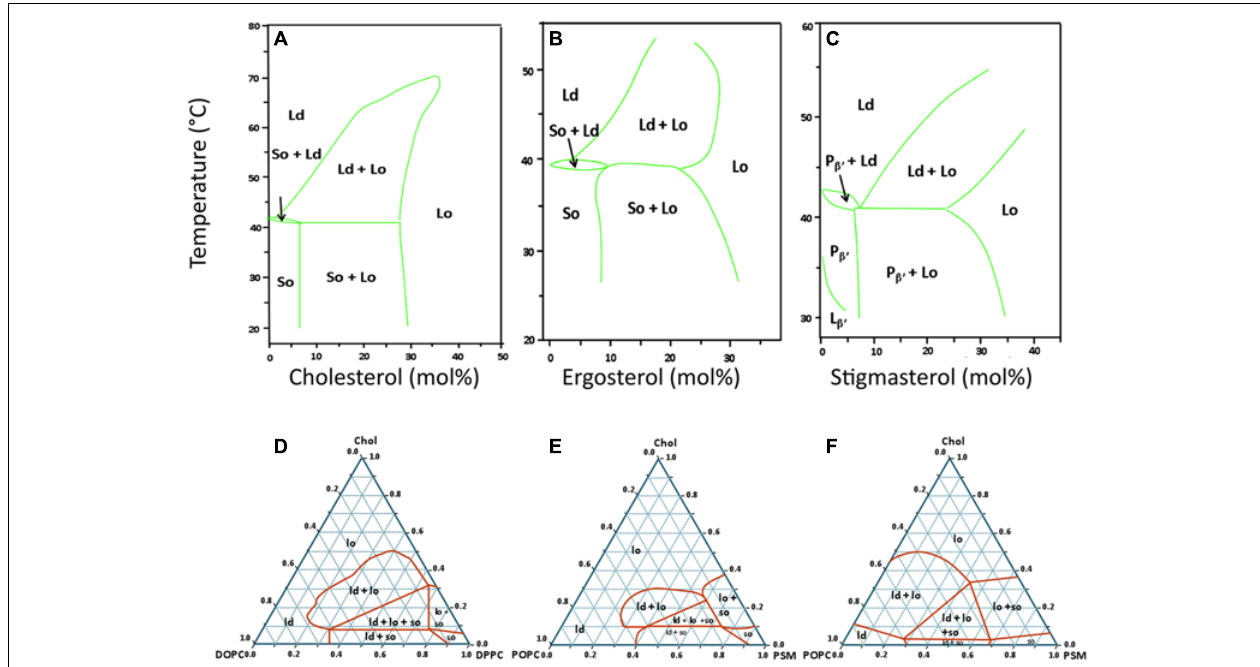
FIGURE 1 |Typical lipid phase diagrams used in the study of sterol-related membrane domains. Top row: temperature – composition binary phase diagrams for mixtures of DPPC with three different sterols (A) Cholesterol (animals; Sankaram andThompson, 1991) and references therein, (B) Ergosterol (fungi; Hsueh etal., 2005), (C) Stigmasterol (plants;Wu etal., 2006).These three diagrams were selected to show that, for the same saturated lipid (DPPC), the type of phase diagram and the regions of coexistence of Ld, Lo, and/or So phases are similar for the three eukaryotic kingdoms. For panel C , the techniques used allowed to distinguish two types of gel phases below the T m : the tilted gel phase ( L β (cid:3) ) and the periodic quasi-lamellar gel phase ( P β (cid:3) ). Bottom row: ternary phase diagrams for mixtures of cholesterol with two other lipids, one with a high T m and the other with a low T m . (D) Typical phase diagram for the DOPC/DPPC/cholesterol system at 24 ◦ C.This mixture is one of the best characterized systems, and the results obtained by different laboratories, even when using different